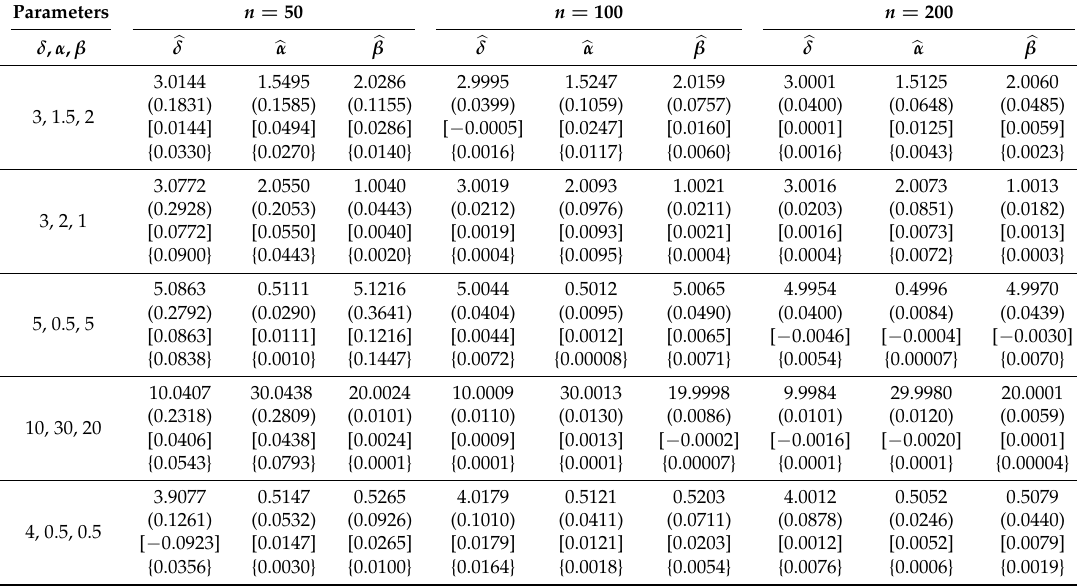
Table 2. The empirical means, sds (given in ( · ) ), biases (given in [ · ] ) and MSEs (given in {·} ) for the special BXP